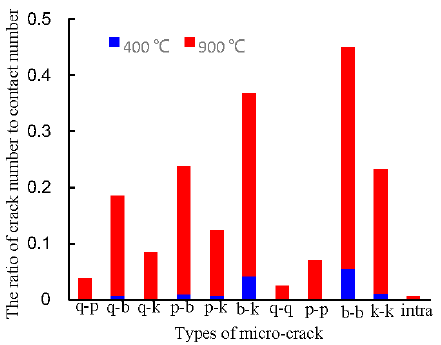
Figure 5. The ratio of the crack number to the corresponding contact number of granite specimens at different temperatures.